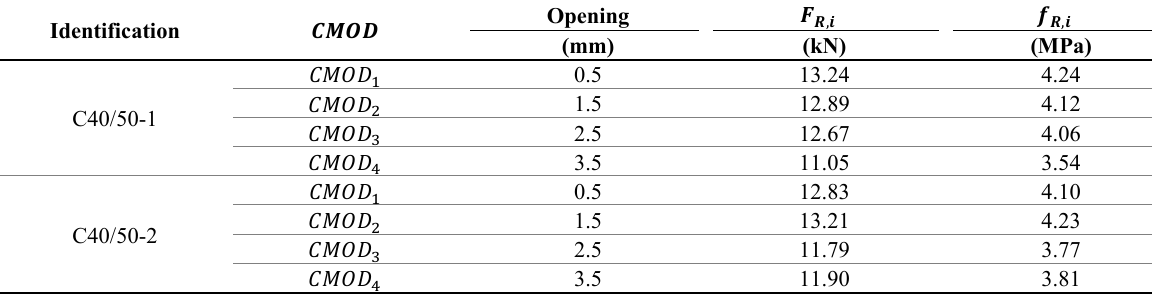
Table 7. Steel fibers reinforced concrete P x CMOD properties from Silva [26]